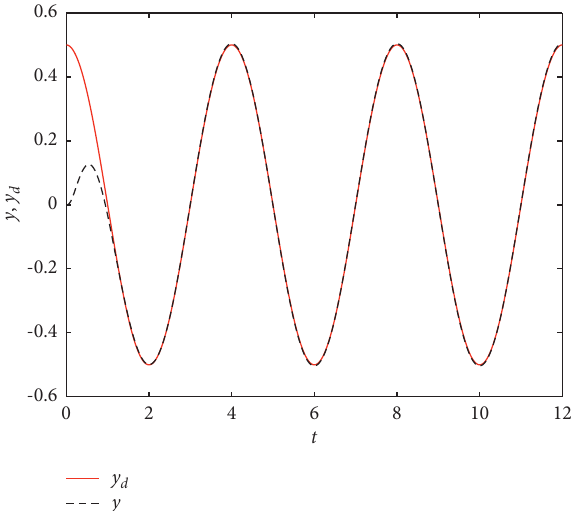
Figure 7: The reference signal y